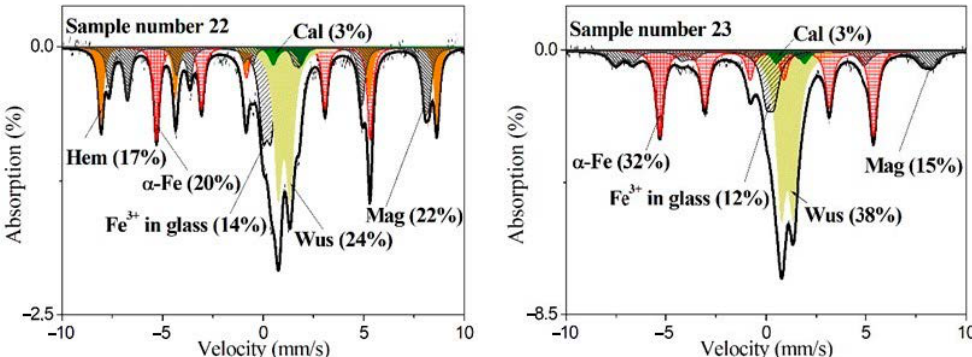
Figure 15. Mössbauer spectra obtained for iron-bearing sludges (No. 22, 23). Fitted subspectra, their assignments and contributions are visible on the spectra; Hem—hematite, Mag—magnetite, Wus—wüstite, Cal—calcite. Table 4. Fe-bearing phases concentration (in % with an error ± 1%) of dust from iron smelting processes on the basis of Mössbauer spectroscopy analyses.